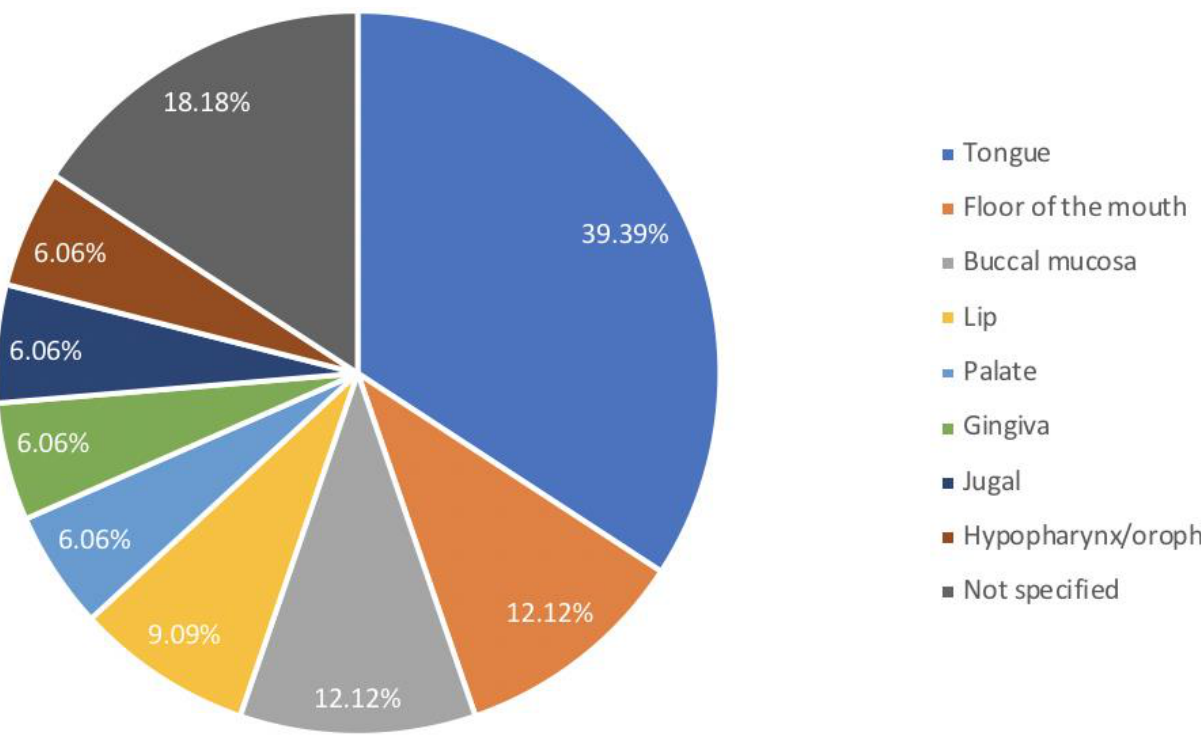
Table 1. Published data about oral cancer among pediatric patients affected by GVHD after HSCT.